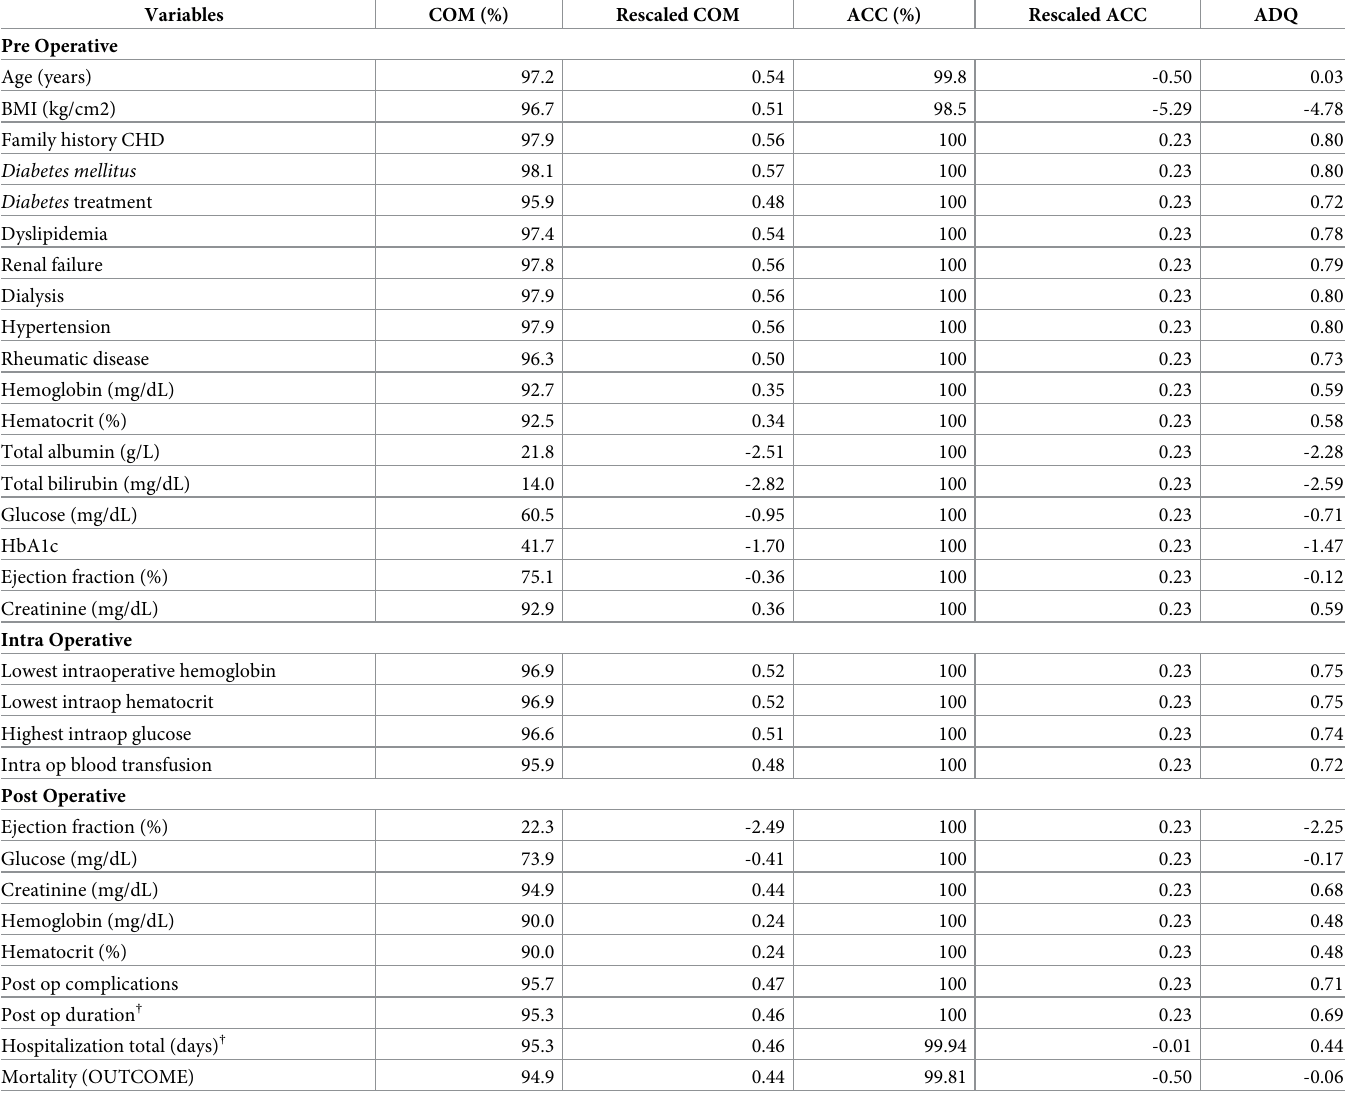
Table 4. ADQ score of completeness and accuracy of REPLICCAR II database (n = 2229),